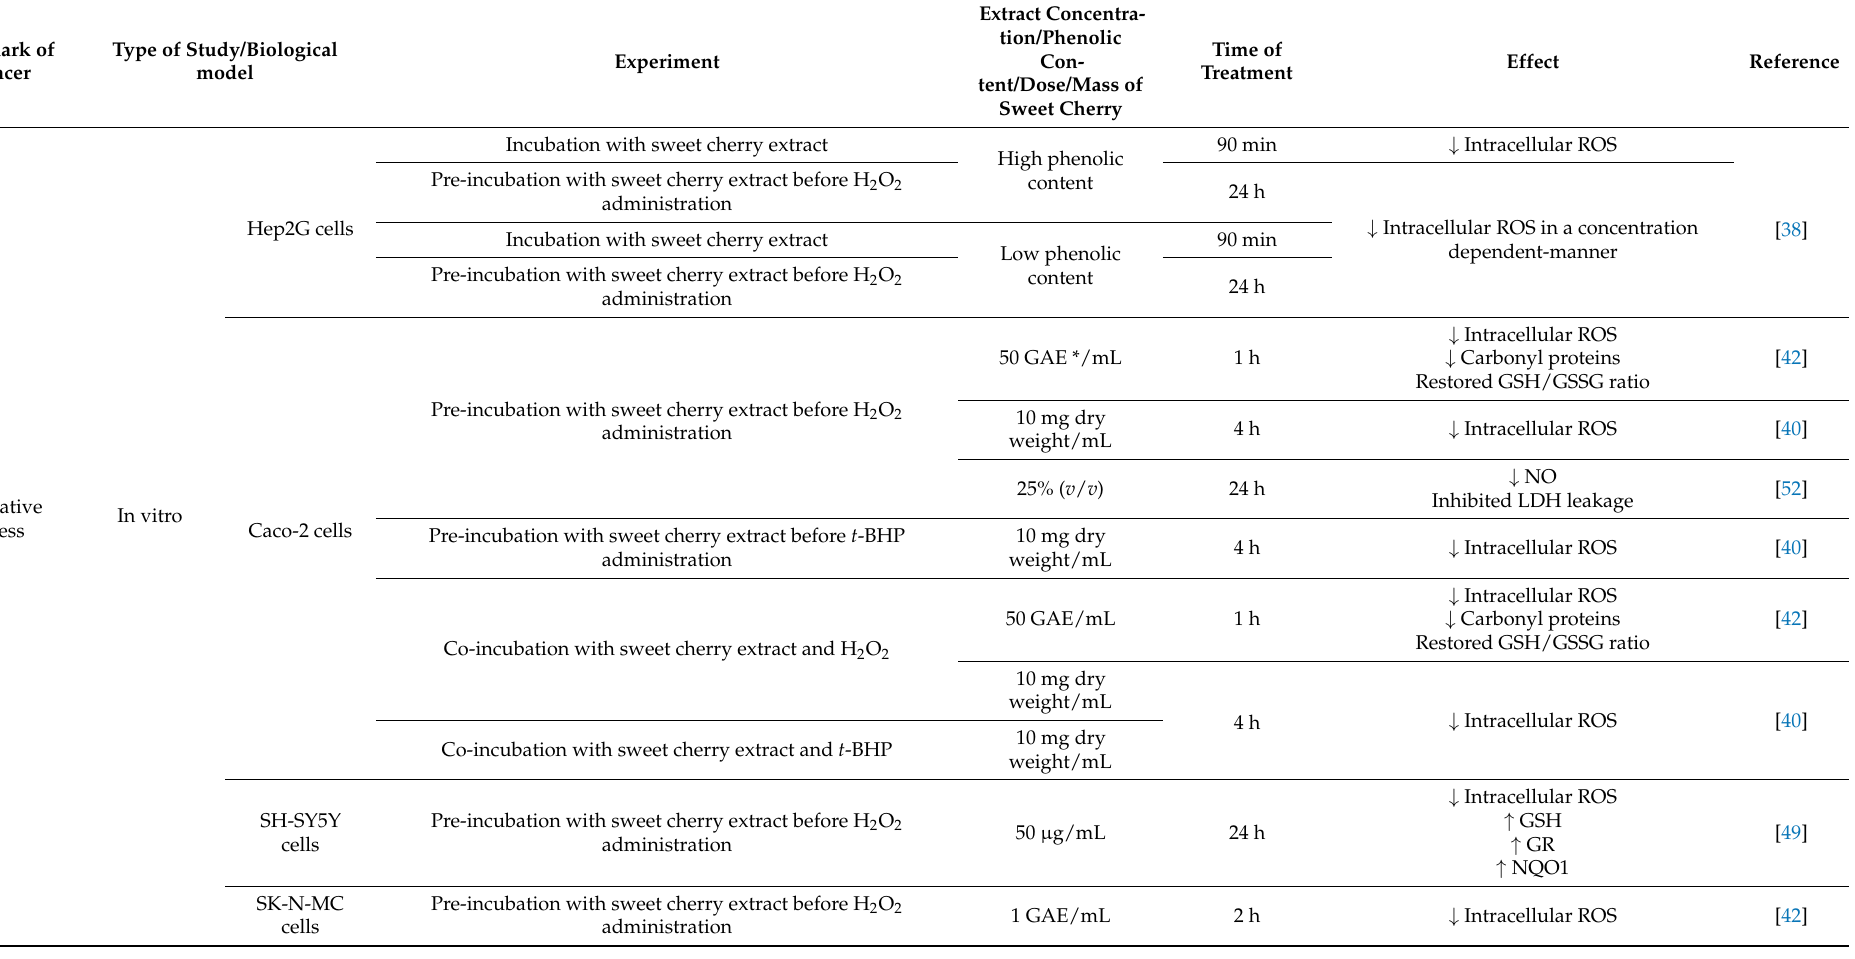
Table 2. Summary of the biological effects of sweet cherry extract and bioactive compounds targeting cancer